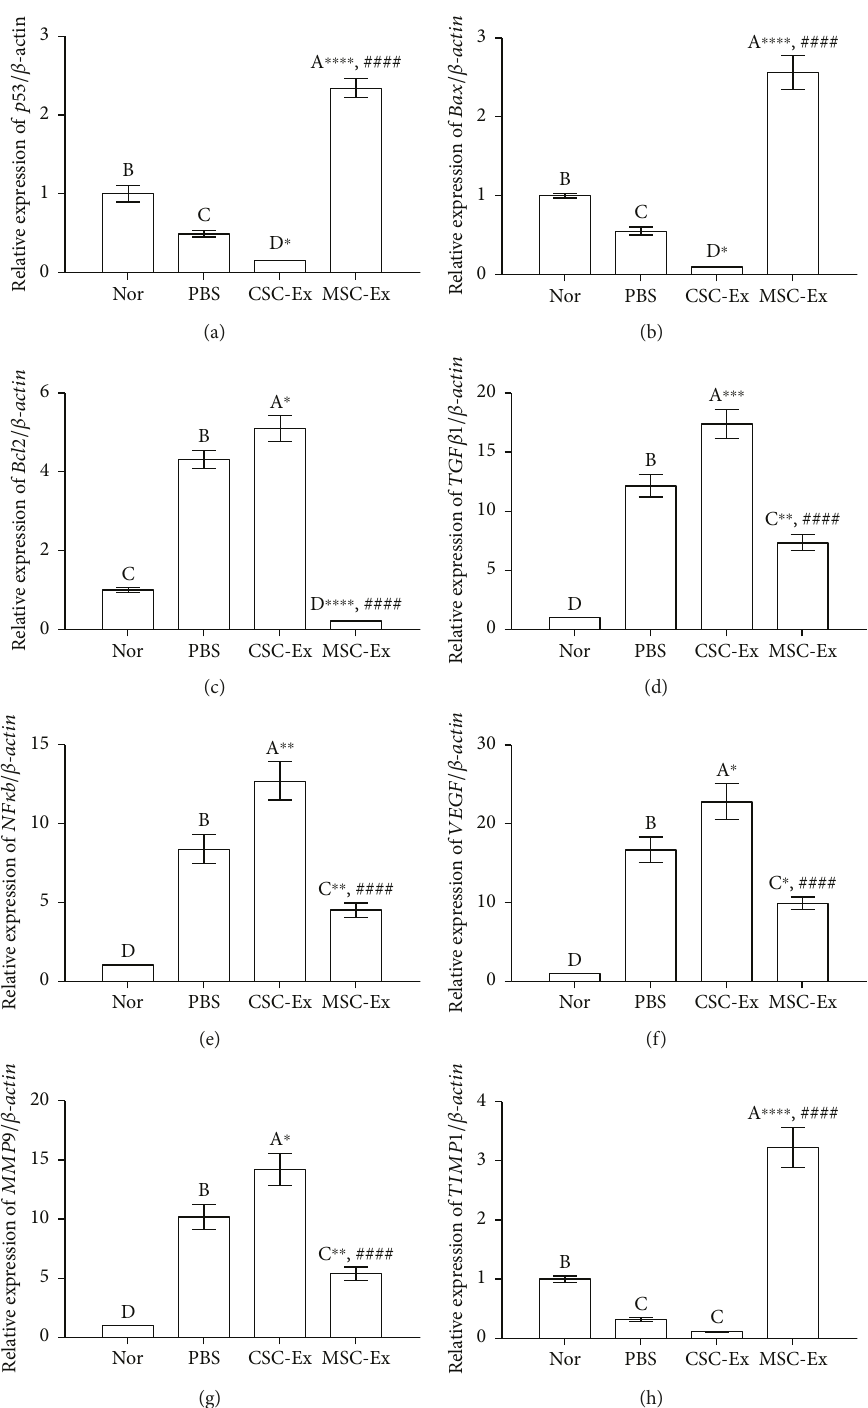
Figure 7: qPCR analysis shows changes in relative gene expression of apoptotic genes ( p53 and Bax ), antiapoptotic gene ( Bcl2 ), EMT-related gene ( TGF β 1 ), in fl ammation-related gene ( NF κ B ), angiogenesis-related genes ( VEGF ), and metastasis-related genes ( MMP9 and TIMP1 ) in livers of normal rats (Nor) and DEN-induced HCC rats treated by PBS or exosomes derived from CSCs (CSC-Ex) or MSCs (MSC-Ex). Data presented as fold change from the normal (Nor) control group. Values are expressed as fold change mean ± SEM ( n = 9 ). Di ff erent letters on columns mean signi fi cant di ff erence. ∗ P < 0 05 , ∗∗ P < 0 01 , ∗∗∗ P < 0 001 , and ∗∗∗∗ P < 0 0001 versus PBS group; #### P < 0 0001 versus CSC